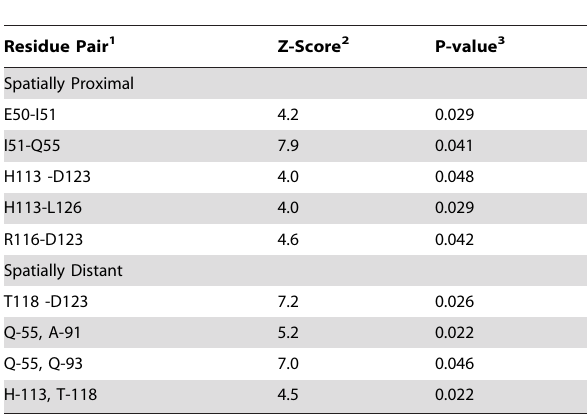
Table 2. List of residues coevolving in